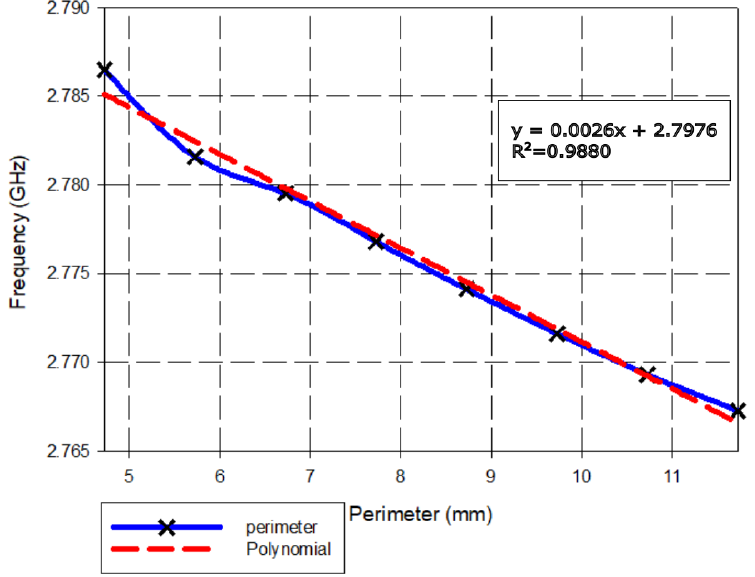
Figure 4. Graph of perimeter of square ring against resonance frequency and regression plot.